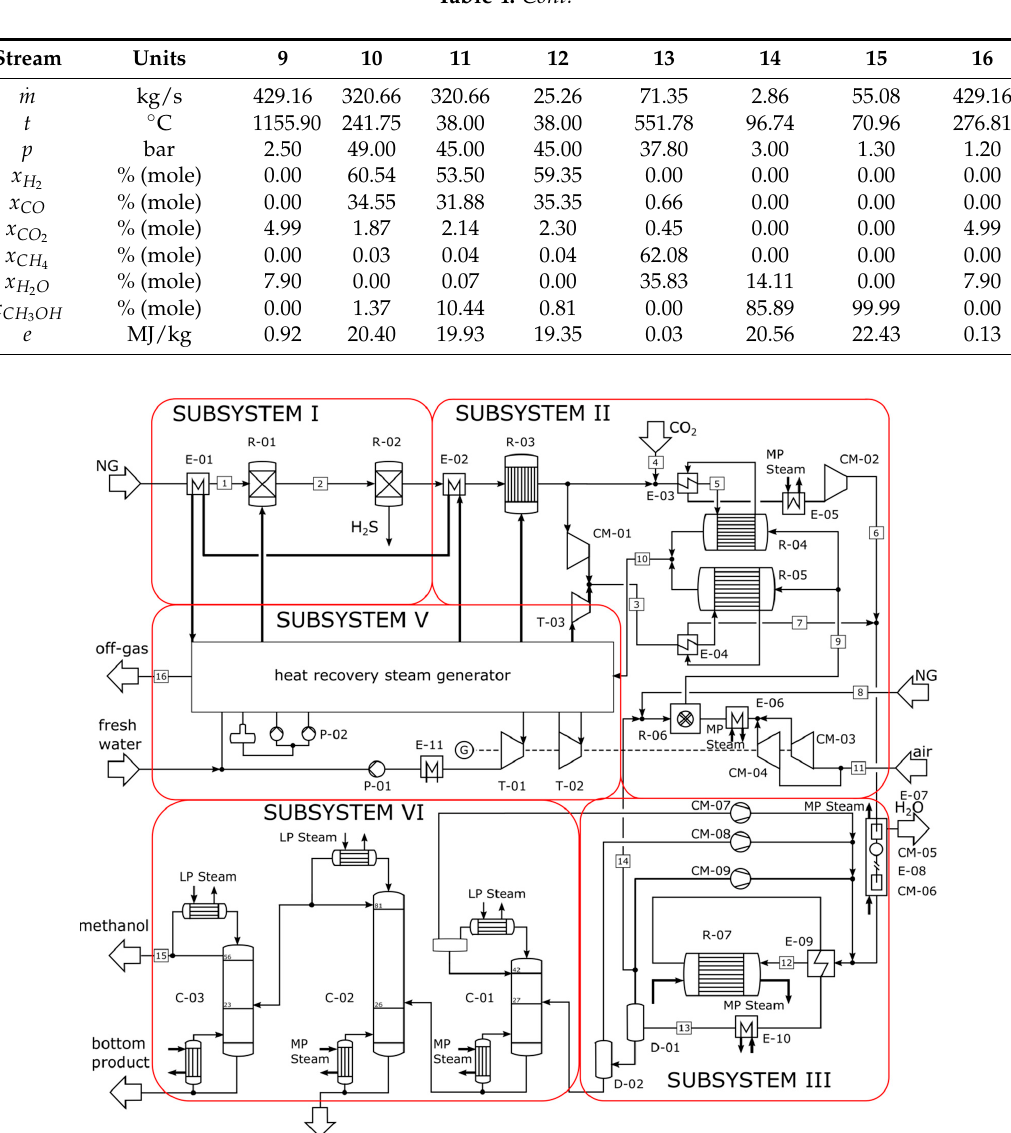
Figure 5. Process flow sheet of the methanol plant with parallel steam-methane and dry reforming (Case III).